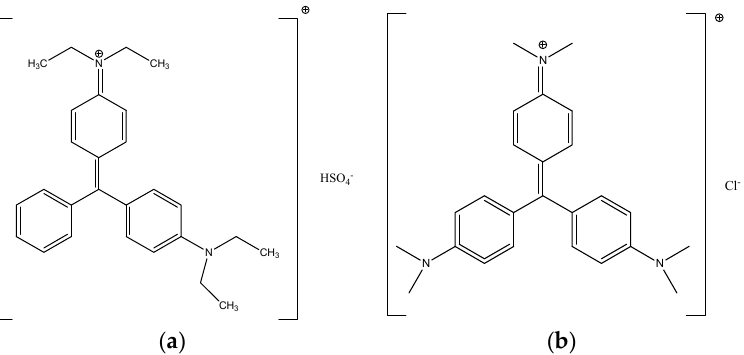
Figure 1. Molecular structure of ( a ) brilliant green and ( b ) crystal violet (see also Table 1).